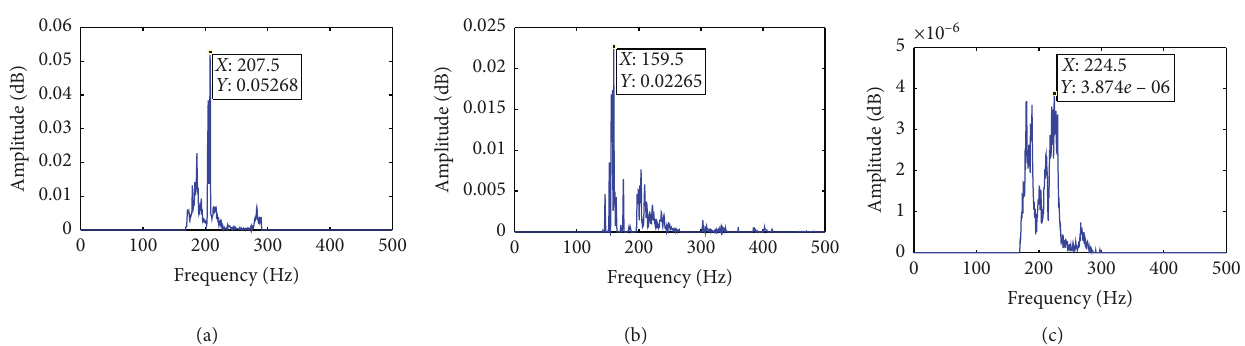
Figure 5: Hilbert marginal spectrum of three types of piezoelectric patch signals: (a) normal piezoelectric patch; (b) broken piezoelectric patch; (c) degummed piezoelectric patch.